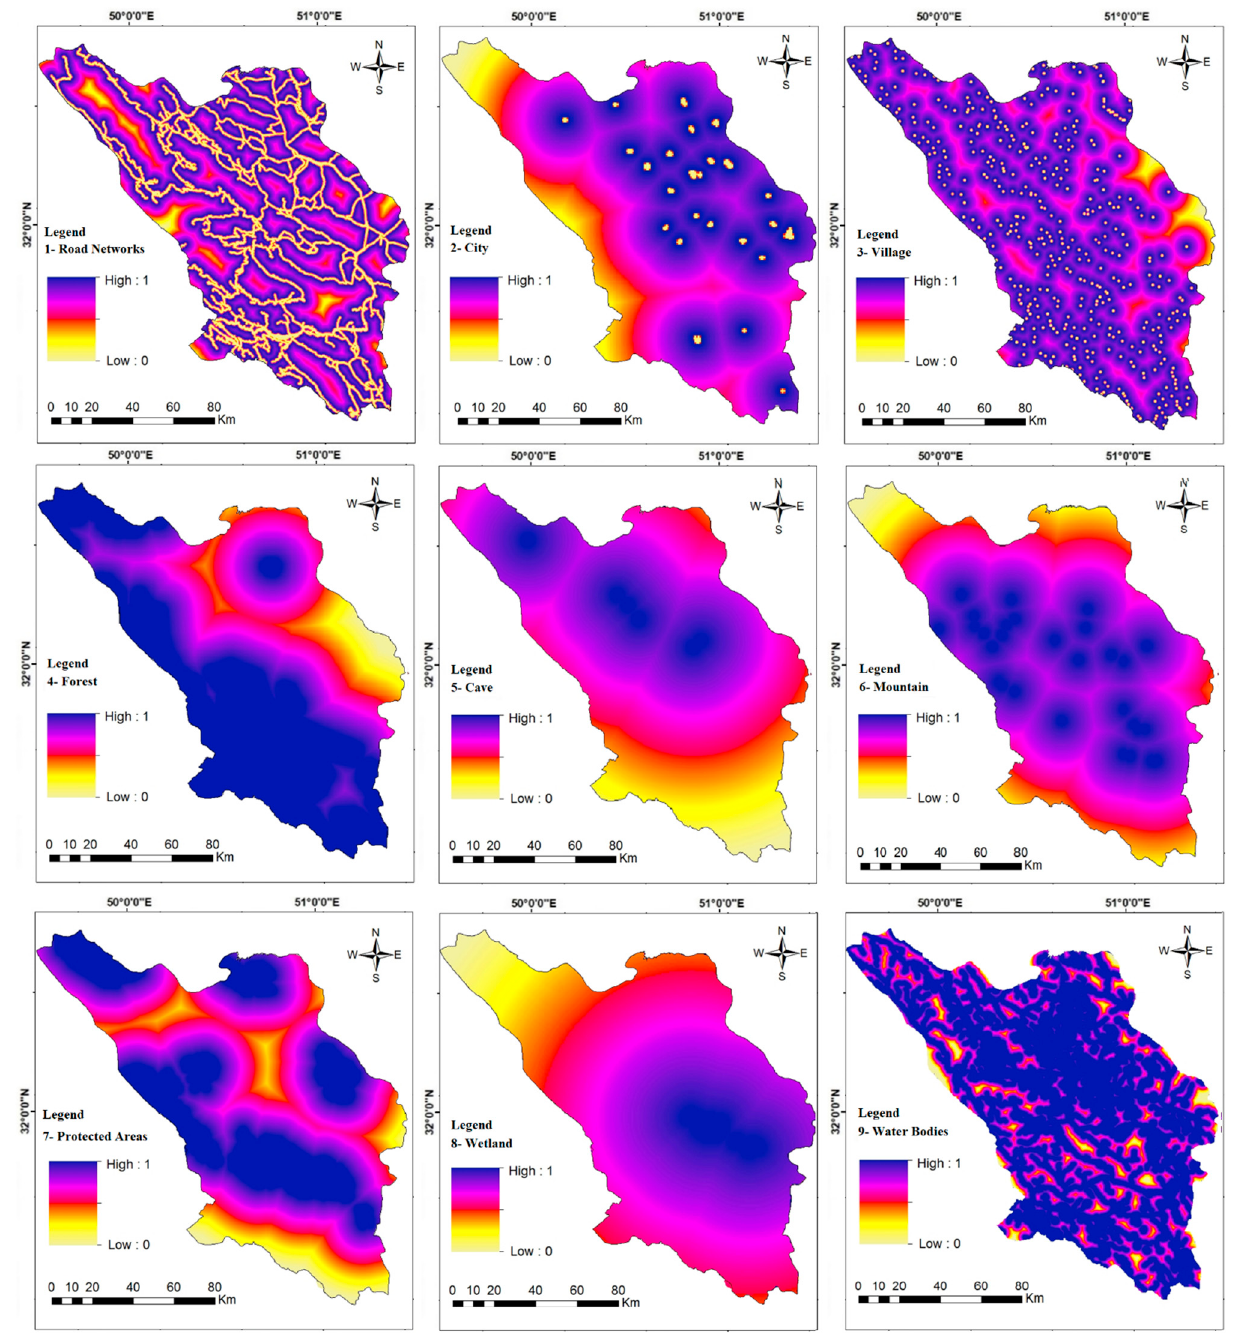
Figure 5. Fuzzy maps of 1—road networks, 2—cities, 3—villages, 4—forests, 5—caves, 6—mountains, 7—protected areas, 8—wetlands, and 9—bodies of water; high values in dark purple represent the high quality for ecotourism development, low values in cream represent the low quality along the different sub-criteria.